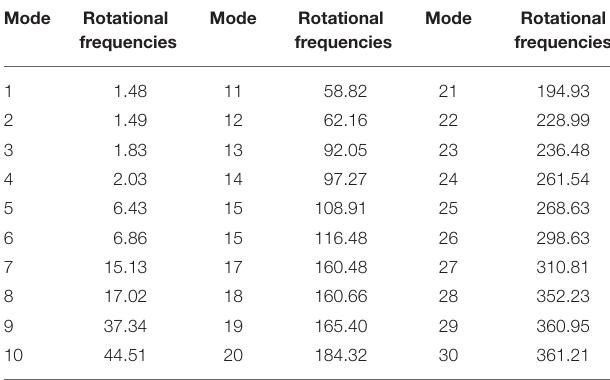
blades of each stage and red triangles show the bearing of the rotor.